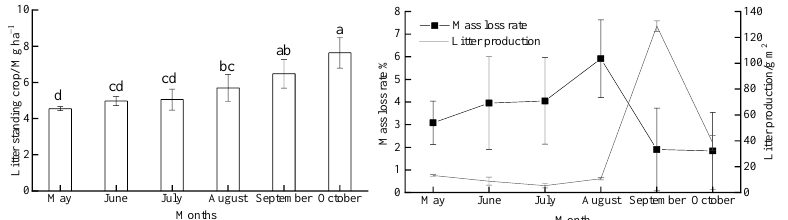
Figure 1. Monthly variations in the litter standing crop, litter decomposition, and litter production during our study period ( n = 5). The different lowercase letters above the bars show the significant difference ( p < 0.05) among months; values are the mean ± SD.